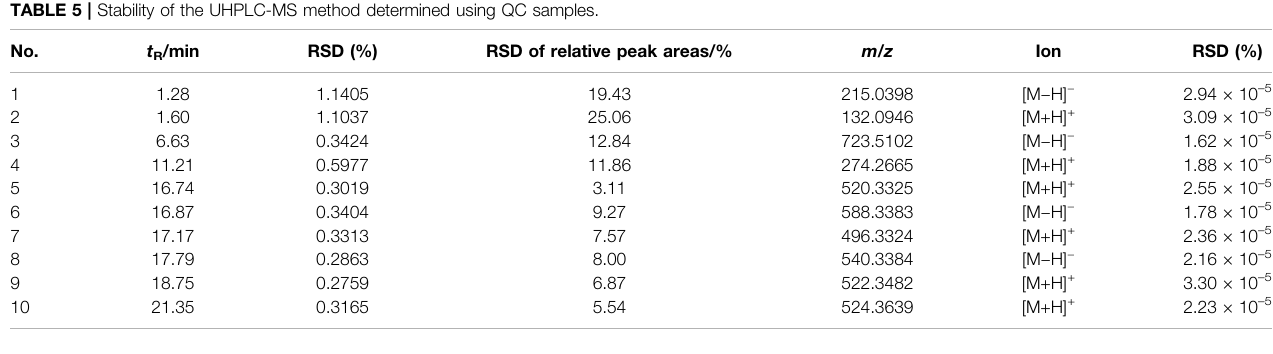
TABLE 5 | Stability of the UHPLC-MS method determined using QC samples.